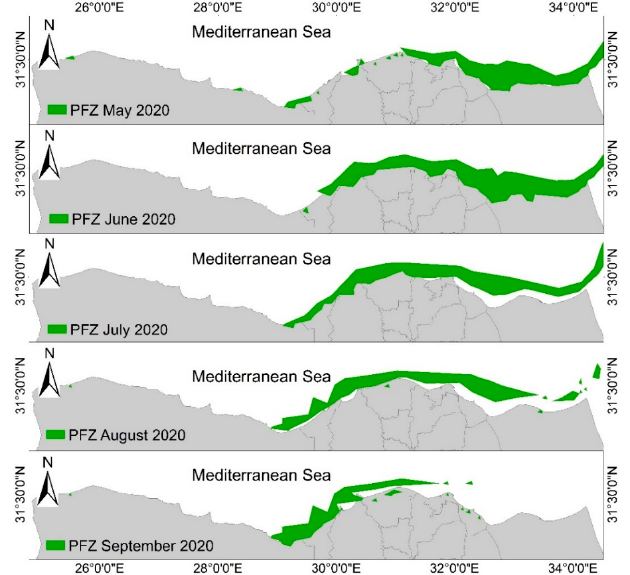
Figure 8. The monthly detected Potential Fishing Zones for Sardinella aurita over 2020 (May–September).